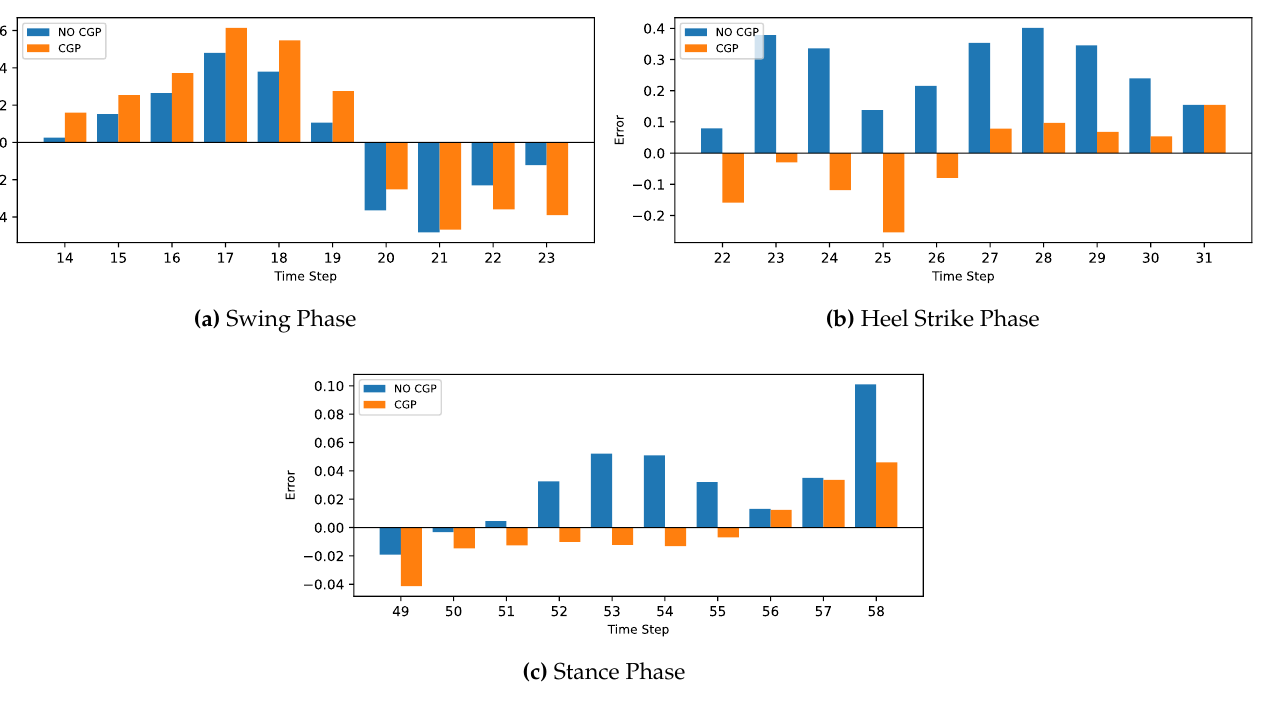
Figure 12. Comparison between two cases, with and without CGP for CNN model. Figure 13. Comparison between two cases with and without CGP for the CNN